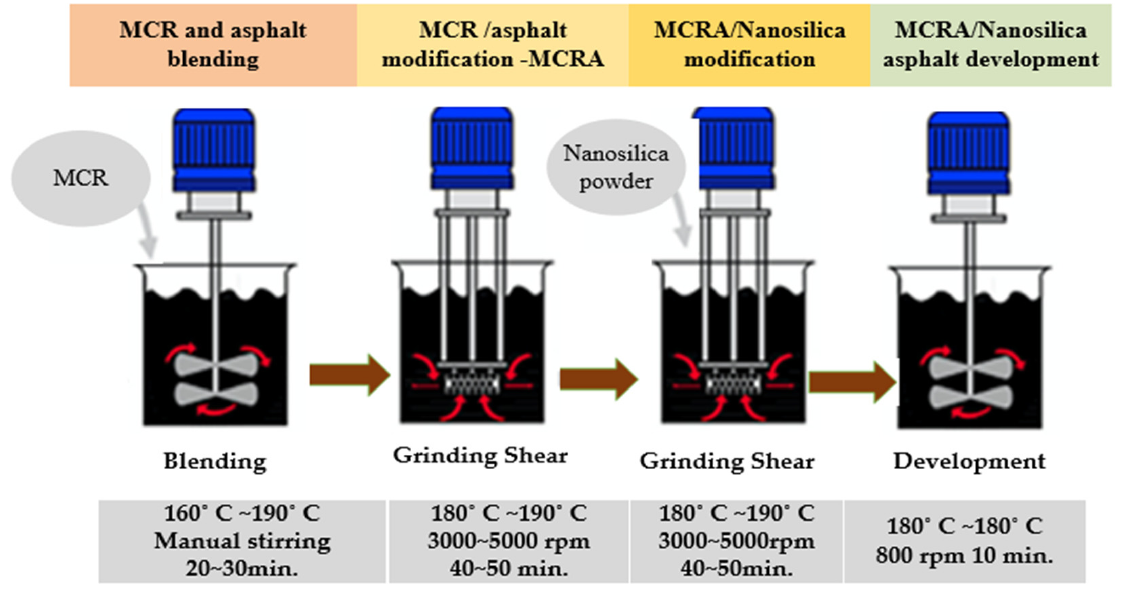
Figure 2. Modification procedure for laboratory preparation of TB rubber/nano silica composite modified asphalt.